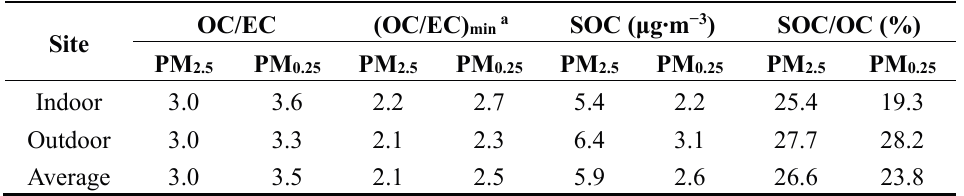
Figure 2. Frequency histogram of OC-to-EC ratios (OC/EC) in PM 2.5 and PM 0.25 inside the classroom and outdoors. Table 3. SOC concentrations in PM 2.5 and PM 0.25 inside the classroom and outdoors, estimated from the EC-tracer